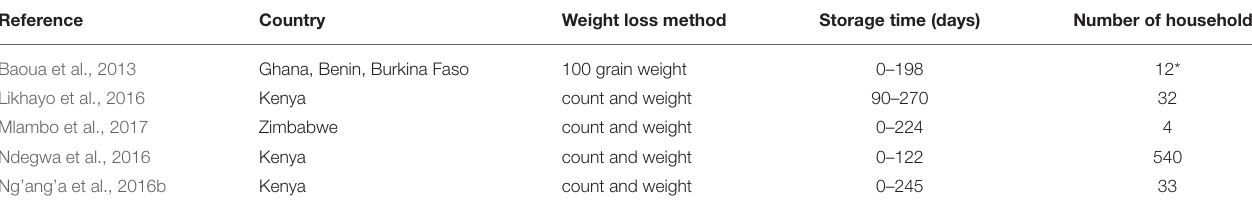
TABLE 1 | Studies used for the estimation of PHL during field trials of stored maize grain in Sub-Saharan African